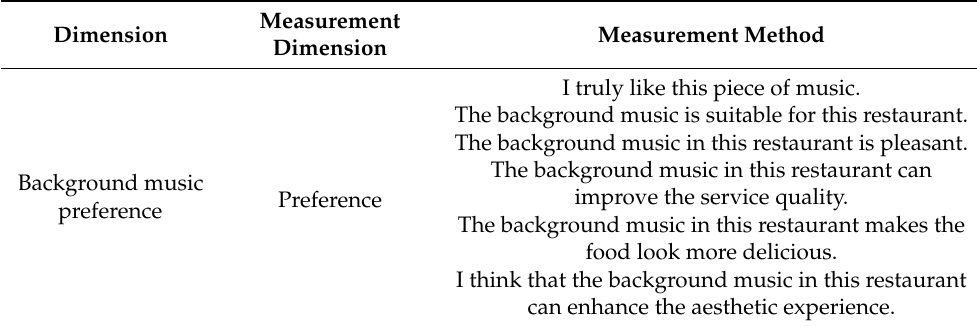
Table 1. Background music preference